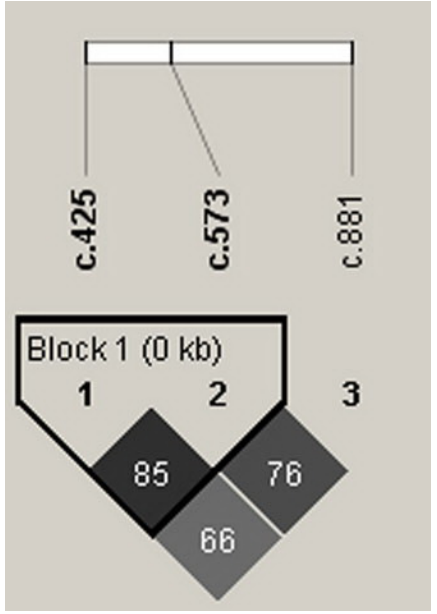
Figure 2. Linkage disequilibrium (LD) plot of three SNPs (c.425, c.573 and c.881) of the porcine OPN gene. The values in squares represent the pairwise D (cid:48) values and the haplotype block is indi- cated by a stronger